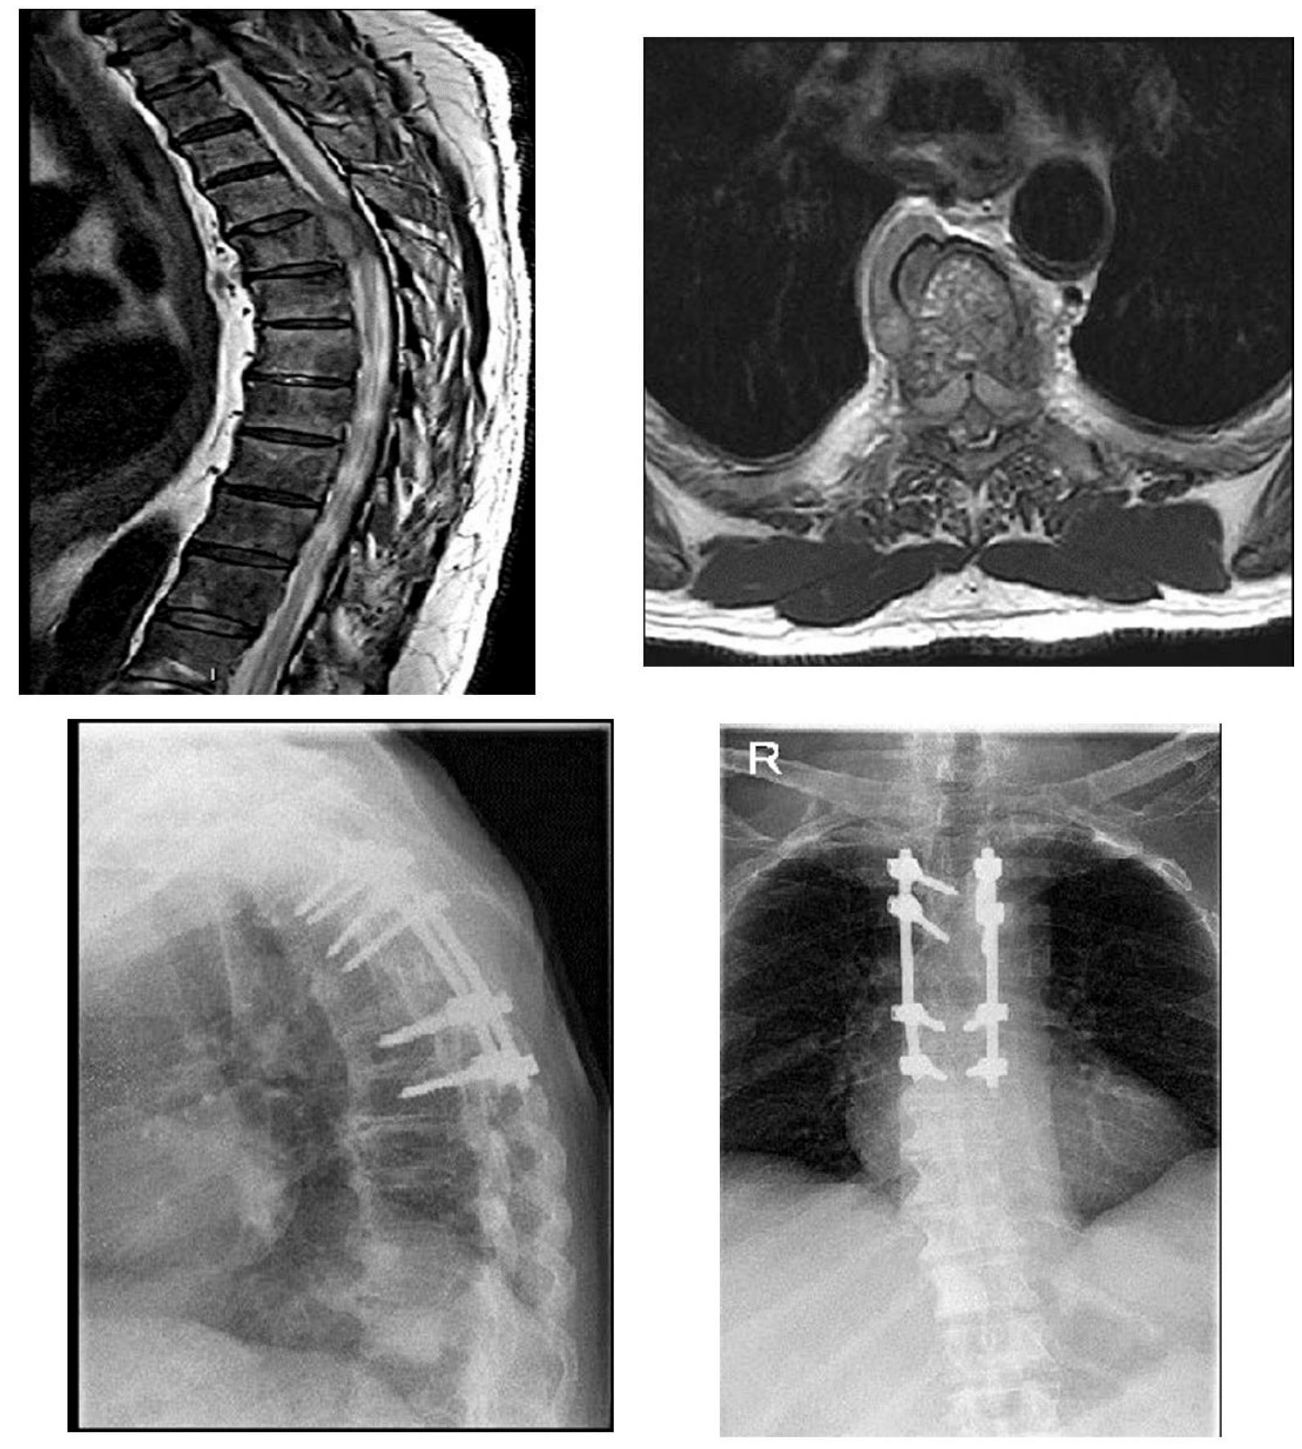
Figure 1. A 78-year-old patient presented to the ER with variable weakness to lower limbs and loss of ability to ambulate. MRI studies revealed a compressing metastasis in D5 as shown on the sagittal and axial T2 images. The patient underwent urgent surgical decompression with partial corpectomy of D5 and stabilization with pedicular screws for two levels above and two levels below the involved lesion. The biopsy revealed a prostate source. Full neurological recovery of motor function was achieved following the surgery.